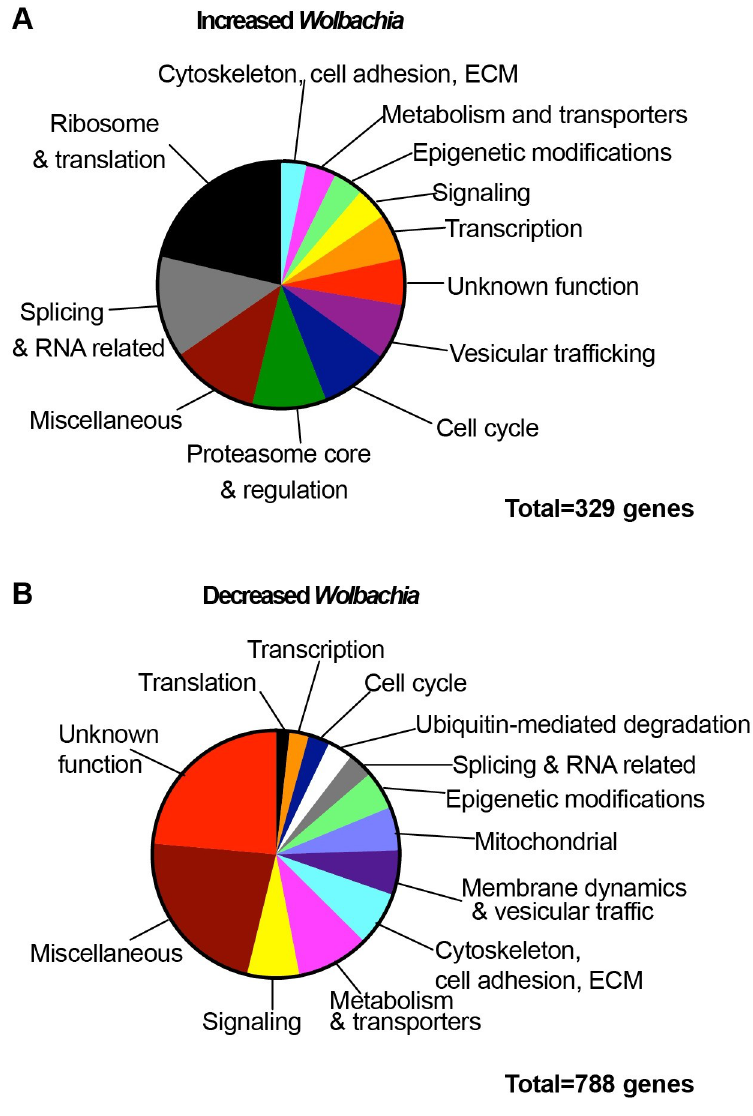
Fig 4. Primary screen hits classified into manually-curated gene categories. (A) 329 primary gene hits that lead to increased Wolbachia levels upon RNAi knockdown manually curated into gene categories. ( B) 788 primary gene hits that lead to decreased Wolbachia levels upon RNAi knockdown manually curated into gene categories. See S7 for GO term analysis.